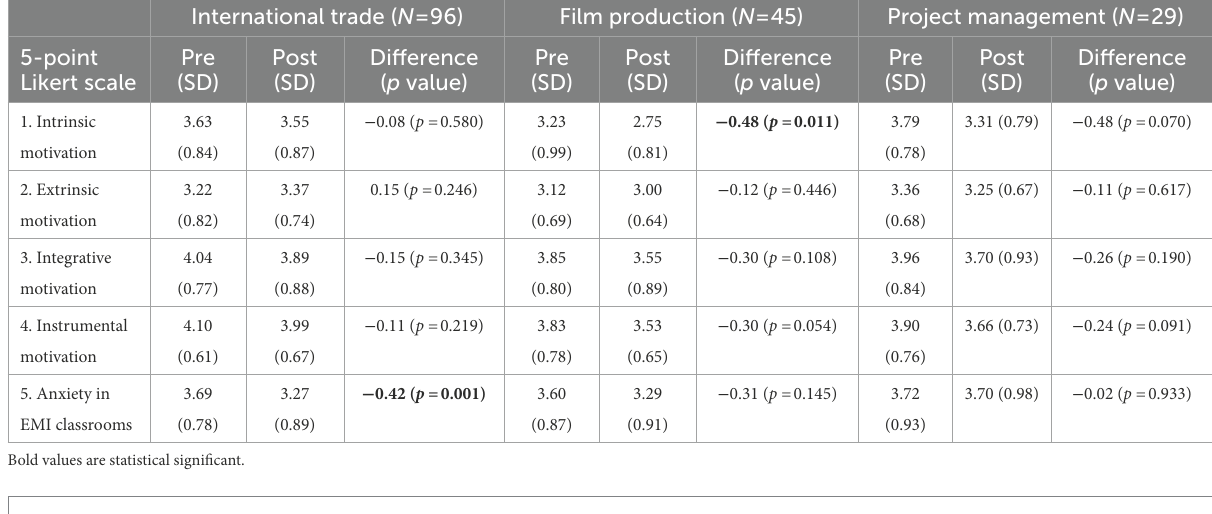
Bold values are statistical significant.